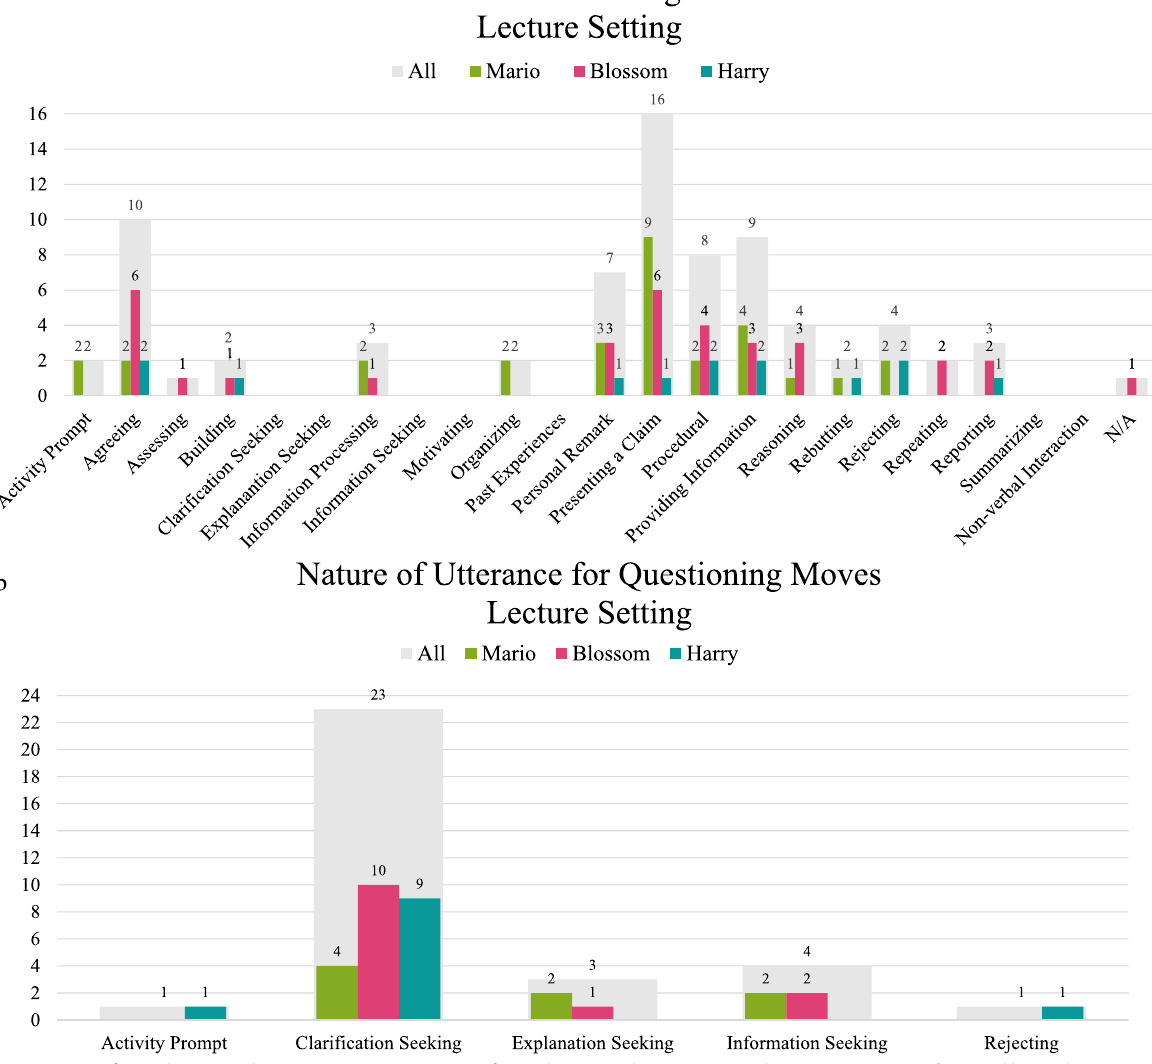
Fig. 4 Nature of contributing and questioning moves. Nature of contributing to discussion ( a ) and questioning moves ( b ) stated by students Mario, Blossom, and Harry in the lecture